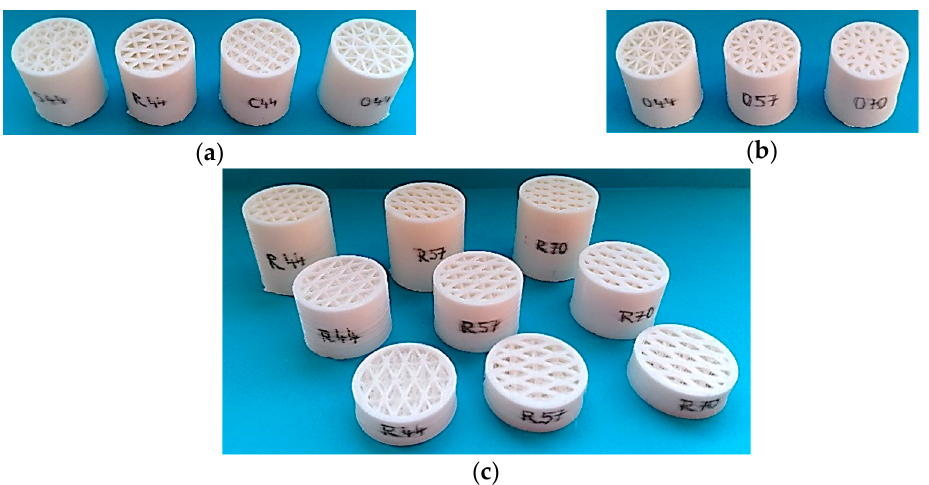
Figure 1. The examples of investigated samples: ( a ) di ff erent shapes of porous structures; ( b ) di ff erent volume ratios Vr of the Octagonal structure; ( c ) a set of the specimens of the Rhomboid structure with di ff erent sample thicknesses t = 1, 2, and 3 cm, and with di ff erent sample volume ratios V r = 44, 57, and 70%.